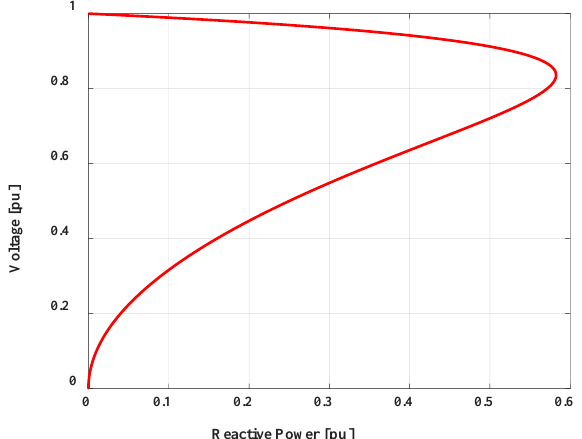
Figure 8. Reactive power control scheme (voltage vs. reactive power characteristic curve).